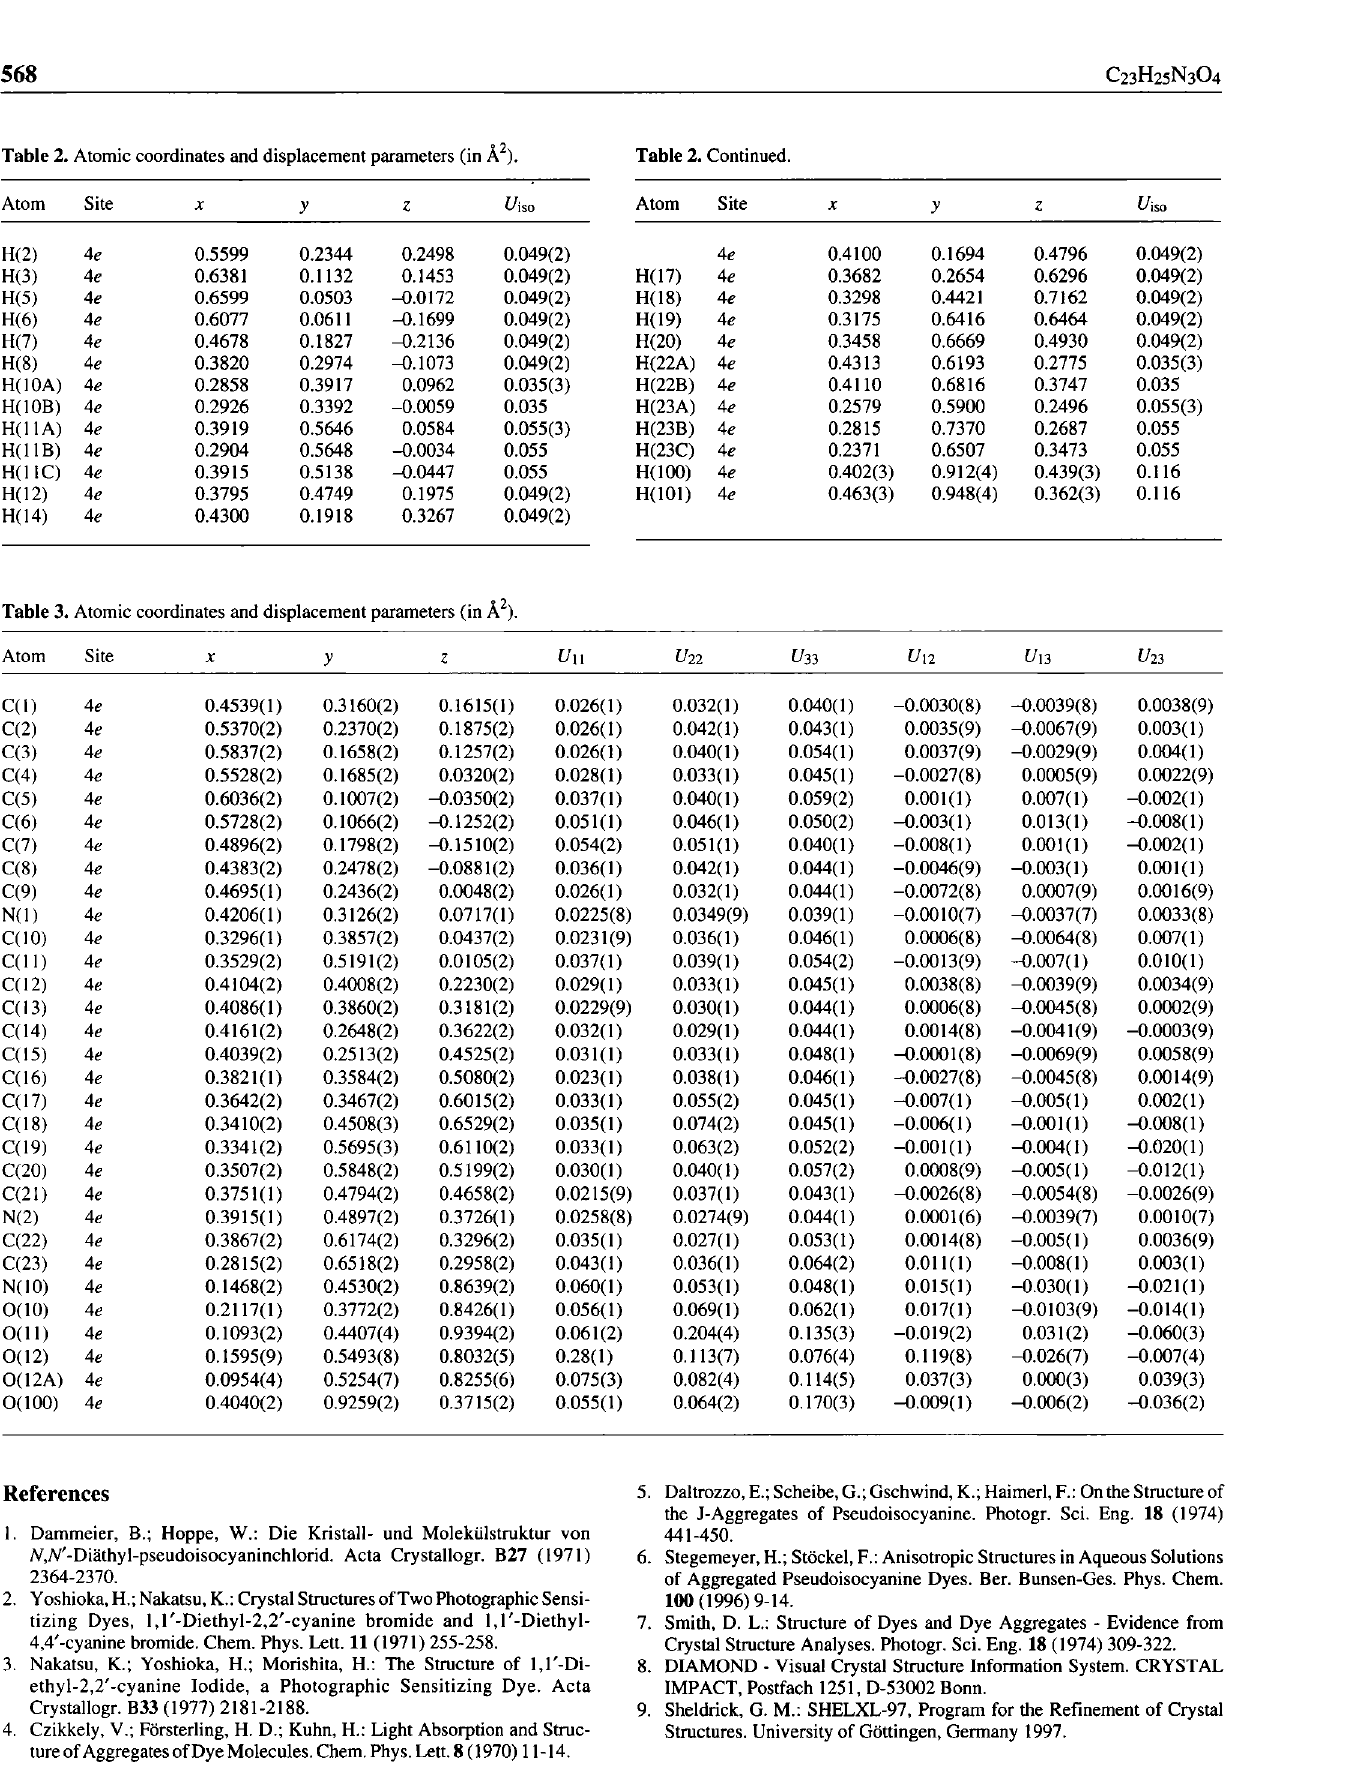
Table 2. Atomic coordinates and displacement parameters (in Ä 2 ).